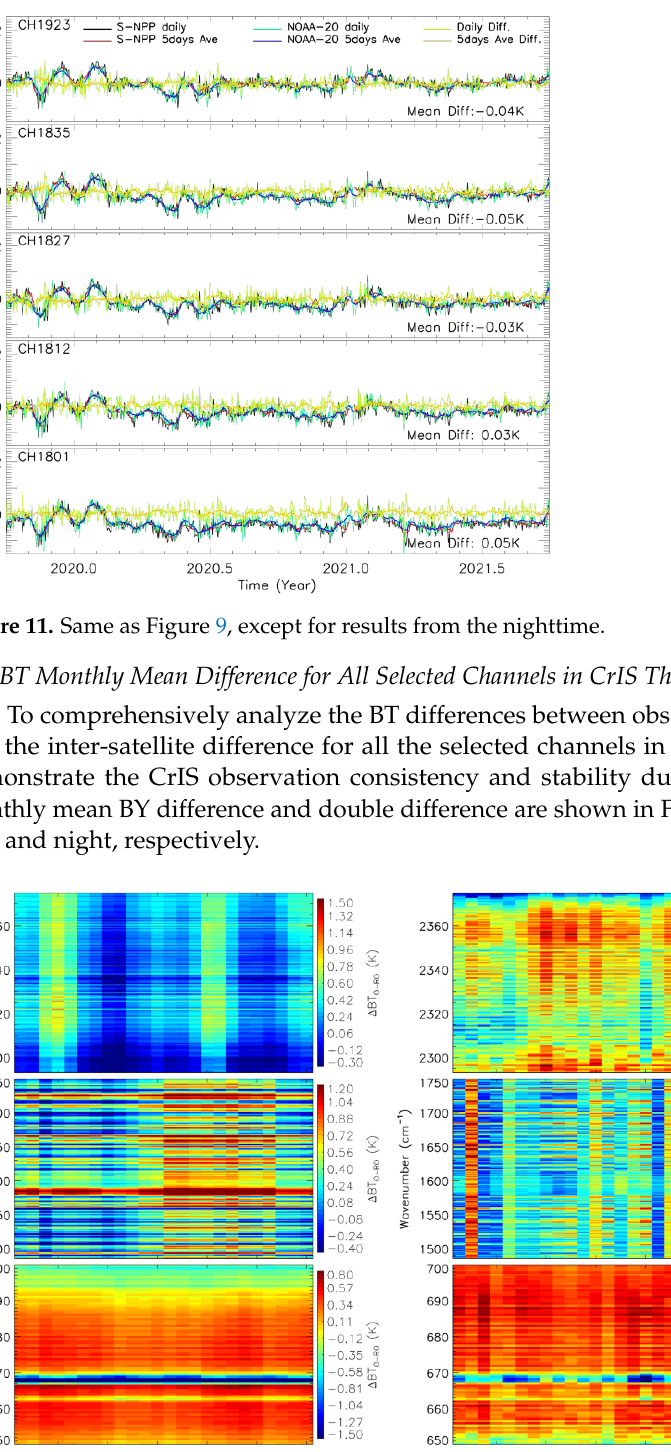
Figure 13. Same as Figure 12 except for results from the daytime.